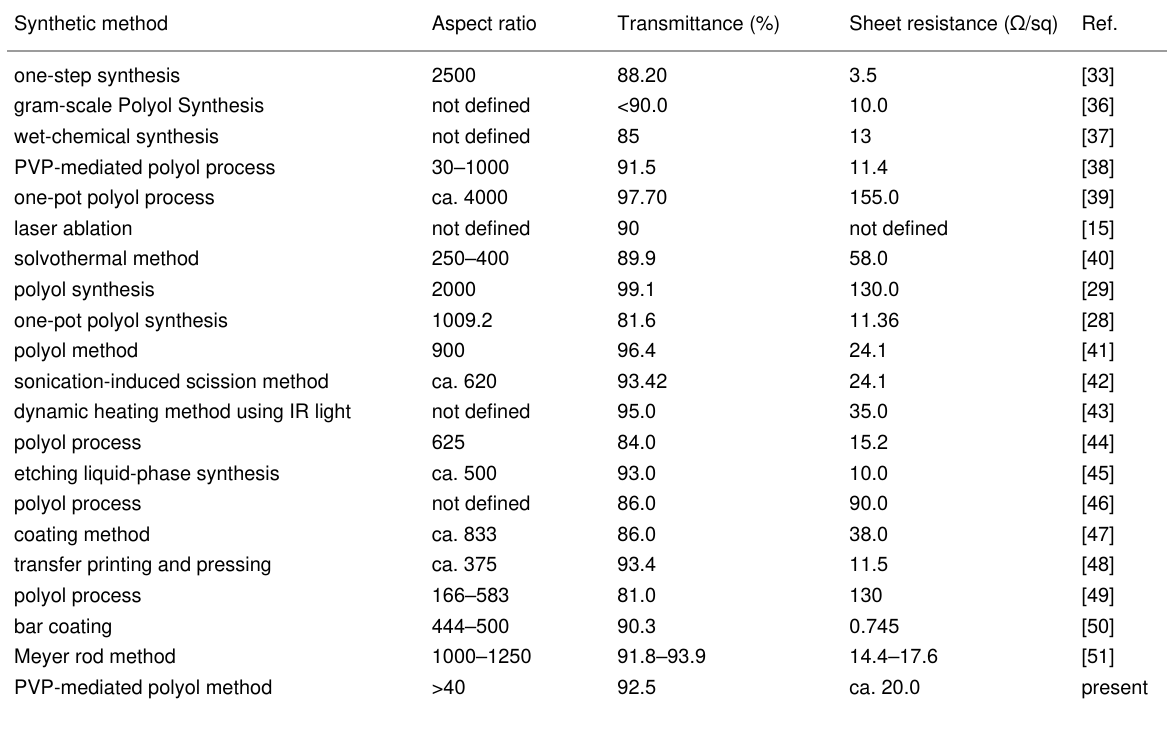
Table 1: A comparison of different parameters of AgNWs synthesized for transparent conducting PET film to present study. Synthetic